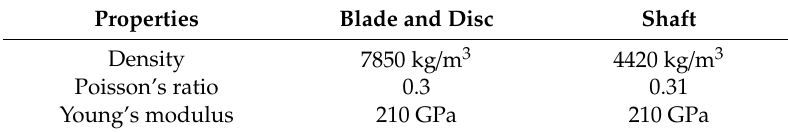
Figure 1. The finite element model of a blade–disc–shaft assembly and its sector model. Table 1. Material properties of the blade, disc, and